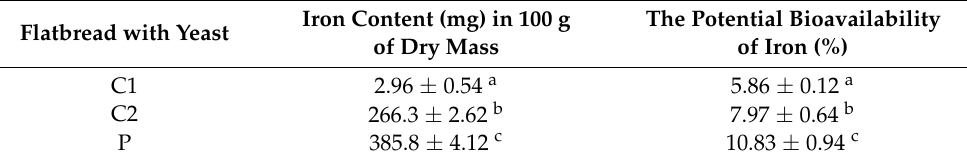
Table 3. Iron content and potential bioavailability of iron from